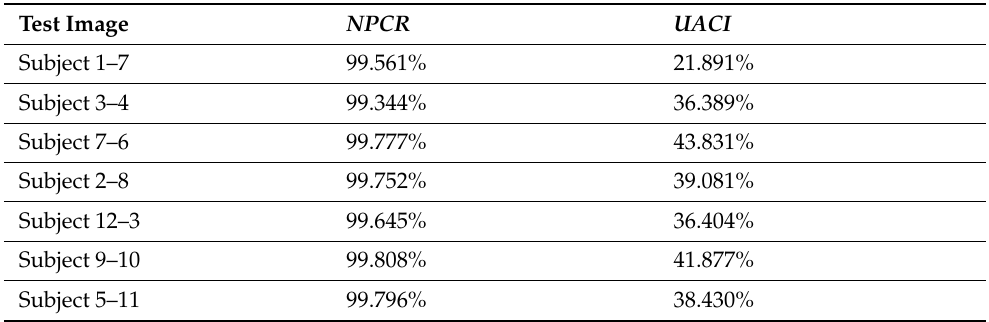
Table 2. Sample of NPCR and UACI between Original Test Images and their encrypted versions